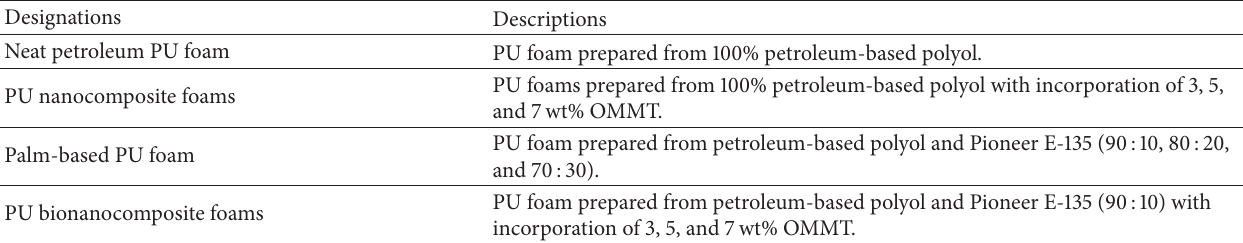
Table 3: Designations of the prepared PU